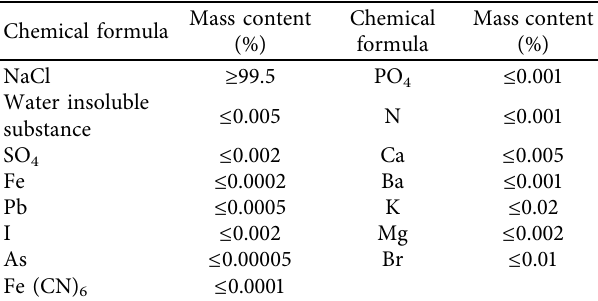
Figure 5: Specimen for pouring. Table 1: Mass indicators for internal components of anhydrous NaCl.